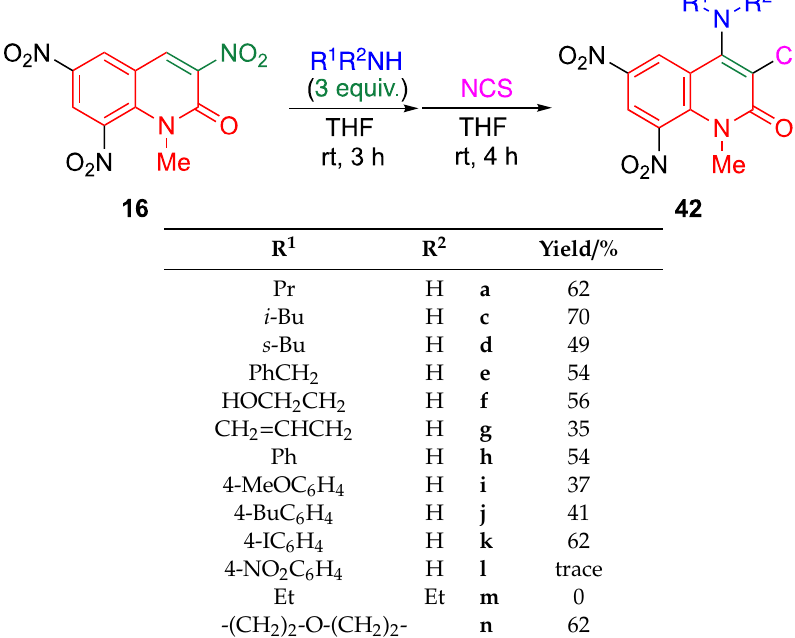
Table 14. One-pot amino-chlorination of trinitroquinolone 16 .